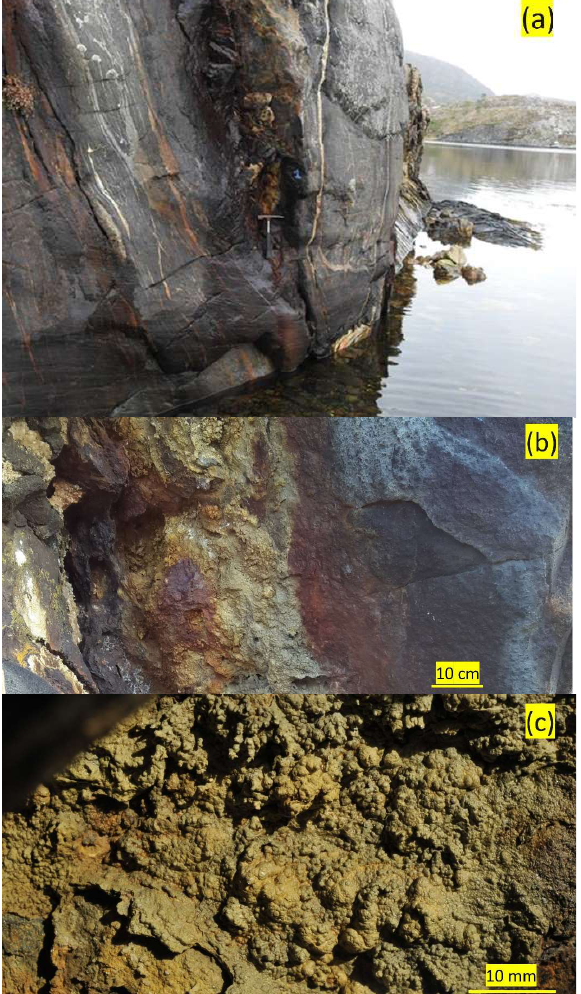
Figure 2. Jarosite formation at Stefføya indicated by a geological hammer ( a ). The middle image ( b ) shows a closer view of the jarosite and the micrograph of the jarosite from the same site is displayed at the bottom ( c ).